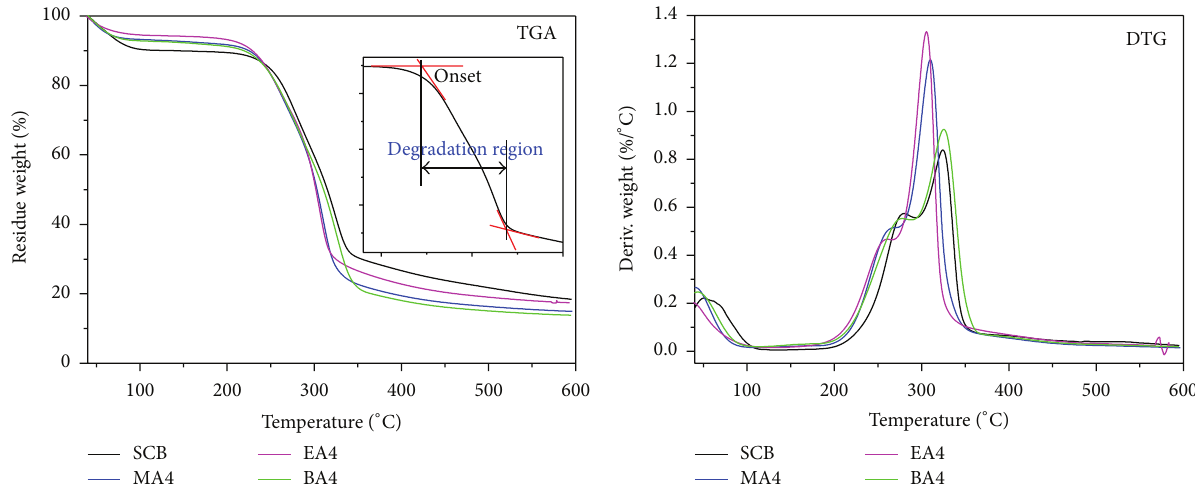
Figure 5: TGA/DTG curves of the sugarcane bagasse graft copolymers. The inset figure in TGA showed the method in determining the onset degradation temperature and the degradation